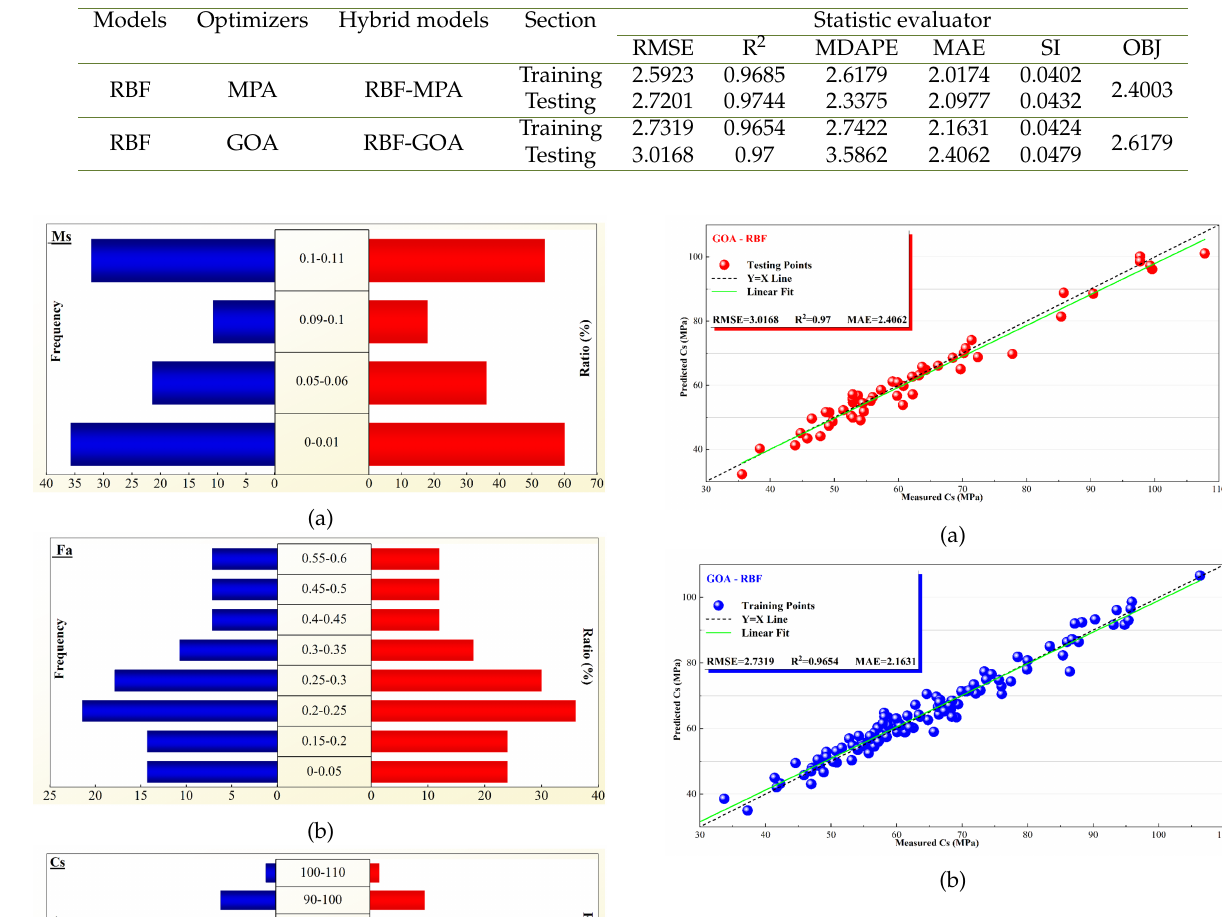
Table 3. The results obtained from the proposed models